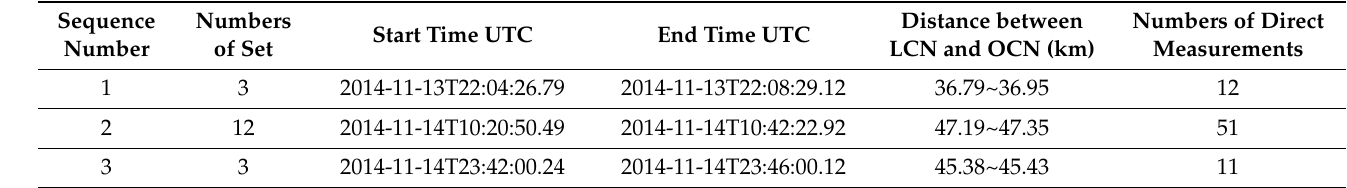
Table 2. CONSERT direct visibility range measurements.